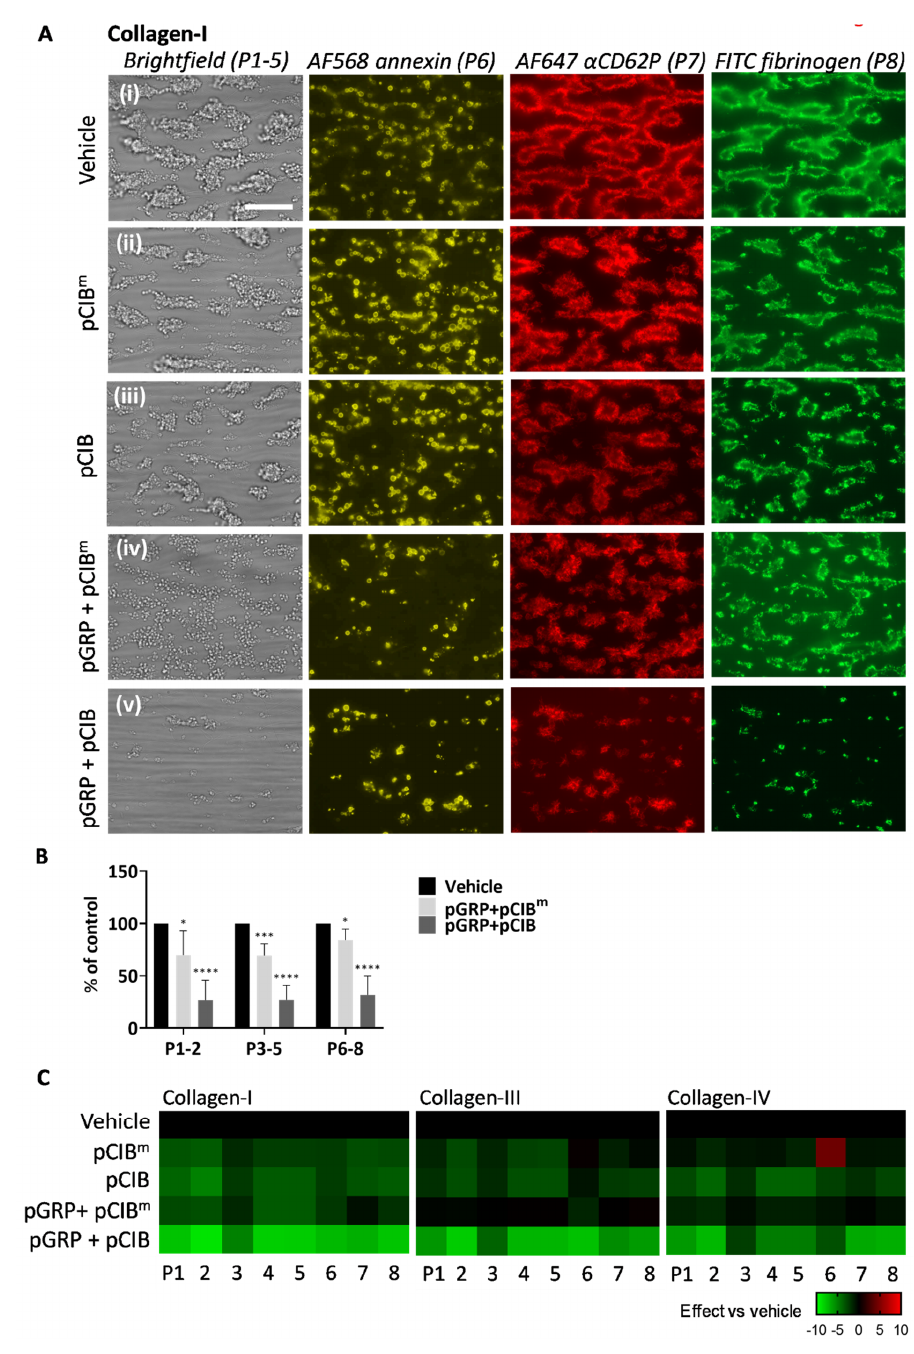
Figure 6. Combined GPR56 and CIB1 peptides affecting collagen-induced thrombus formation. Blood samples were pre-incubated with vehicle medium (control) or indicated peptides pGRP, pCIB, and pCIB m (50 µ g/mL each) for 10 min. Thrombus formation on collagen I, III, and IV was monitored. ( A ) Representative images for collagen I of ( i ) vehicle control, ( ii ) pCIB m , ( iii ) pCIB, and ( iv ) pGRP + pCIB m , or ( v ) pGRP + pCIB. Scale bar = 10 µ m. ( B ) Percentual effects of peptides on combined parameters of platelet deposition (P1–2), thrombus characteristics (P3–5), and platelet activation (P6–8) versus the vehicle control condition. Additional images and raw data for collagen III and collagen IV are given in Figures S5 and S6. ( C ) Subtraction heatmap representing control-subtracted scaled (0–10) parameter values for collagen I, III, and IV microspots. The color code represents a decrease (green) or increase (red) in comparison to controls. Mean values ± SD (n = 3 donors). * p < <0.05, *** p < 0.001, **** p < 0.0001 vs. vehicle (paired Student’s t